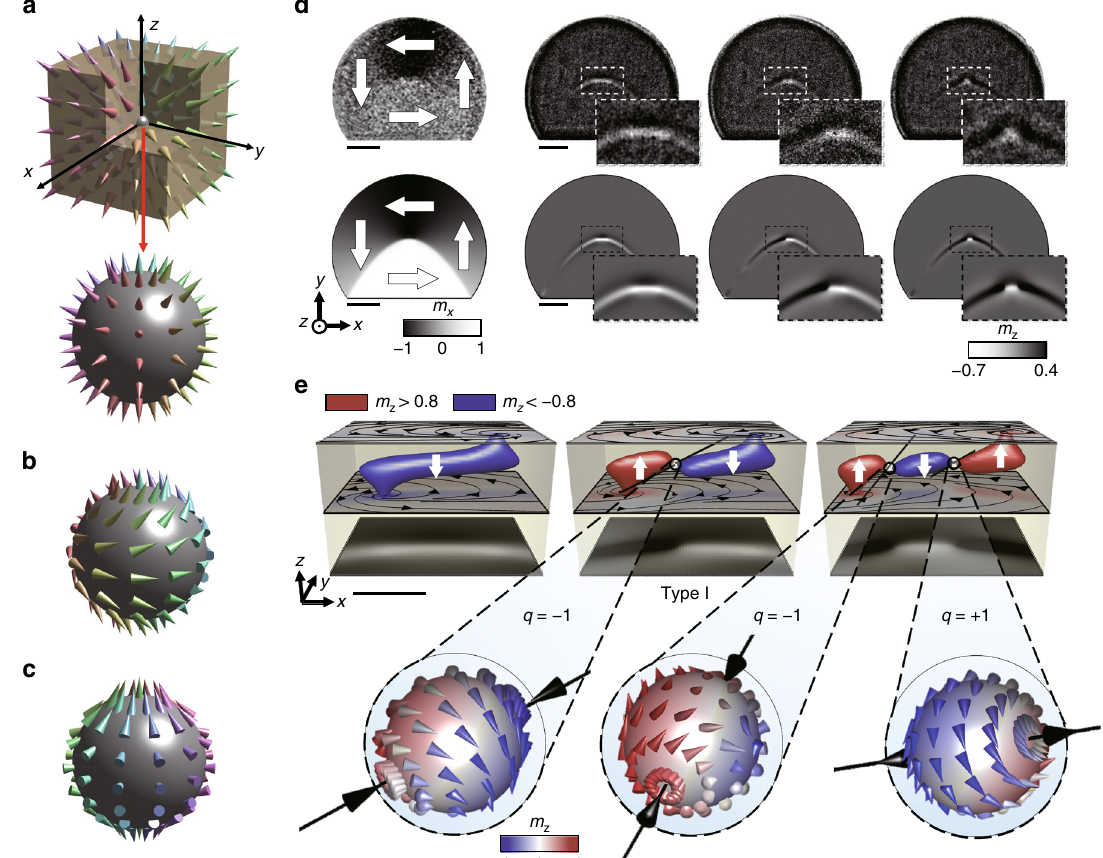
Fig. 1 Direct observation of stabilized Bloch point (BP) structures. a – c Schematic diagram of three possible con fi gurations of a BP with skyrmion charge q = + 1, namely, hedgehog ( a ), circulating ( b ), and spiralling ( c ) con fi gurations where the colour indicates the orientation of magnetization. d In-plane (IP) and out-of-plane (OOP) magnetic components observed by magnetic transmission soft X-ray microscopy (MTXM), and the corresponding magnetic structures determined by micromagnetic simulations. Zoomed images for magnetic con fi gurations near vortex core structures are also inserted. The black and white contrasts in the images of the IP (OOP) magnetic component represent the magnetizations oriented in the left and right directions on the disk plane (perpendicular upward and downward to the disk plane), respectively. e Images of the distorted vortex core structures with no BP (left), a single BP (middle), and double BPs (right), and the con fi gurations of the BPs embedded in the vortex cores. The OOP magnetic components with m z > + 0.8 (red) and m z < − 0.8 (blue) were extracted and the BP con fi gurations were obtained by interpolation from the simulated vortex core structures. The single BP is characterized by q = − 1, while the double BPs are de fi ned by q = − 1 and + 1, respectively. The single-BP core structure here is referred to as type I. Scale bars in ( d , e ) correspond to 500 nm and 50 nm,